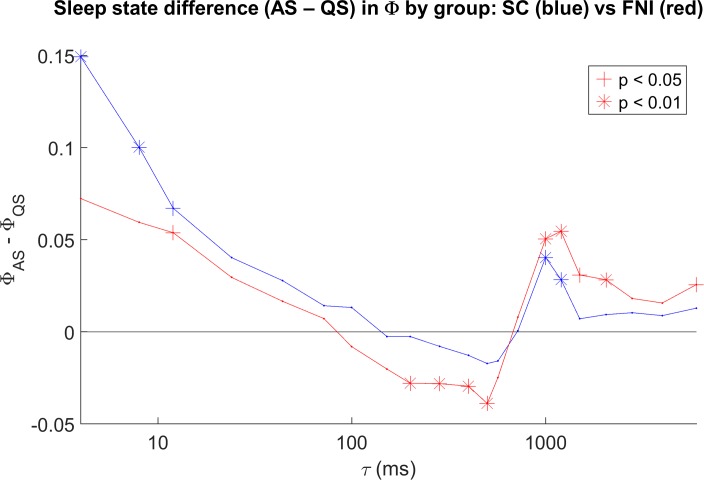
Sleep state differences for all computed values of τ.Results for the FNI and SC groups are shown separately in red and blue, respectively. The median over studies from 37 to 44 weeks postmenstrual age was used for each subject. Significant state differences (paired t-tests) are denoted by asterisks (p < 0.01) and crosses (p < 0.05).